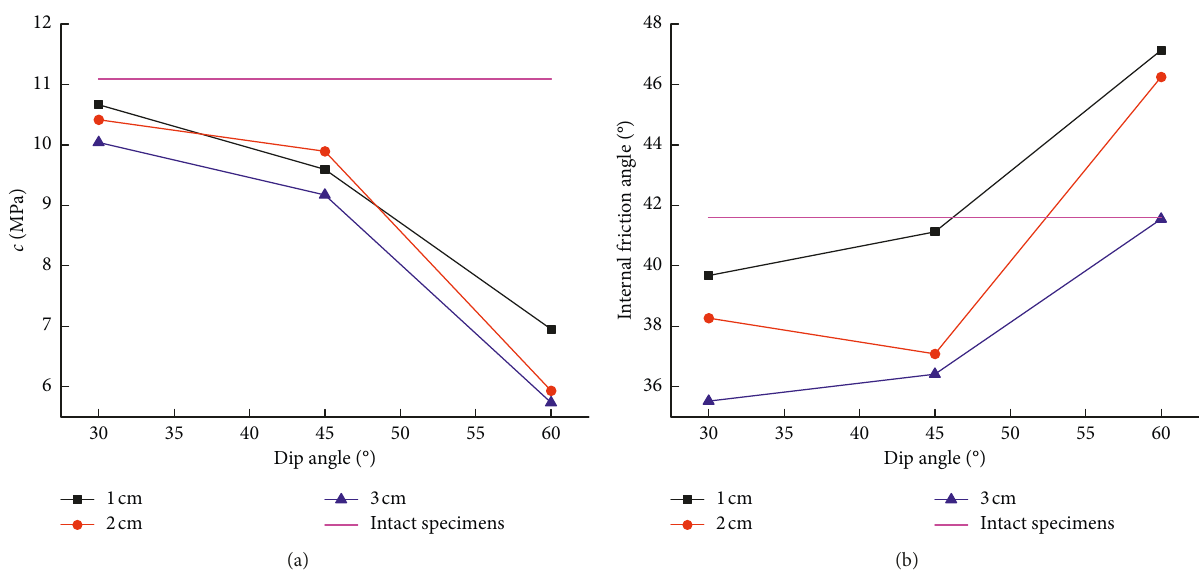
Figure 9: The variation of the cohesion (a) and the internal friction angle (b) of the specimens with the flaw inclination